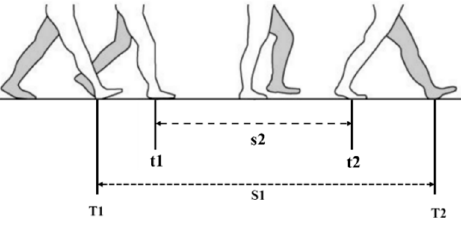
Figure 3. A Typical Step Cycle.